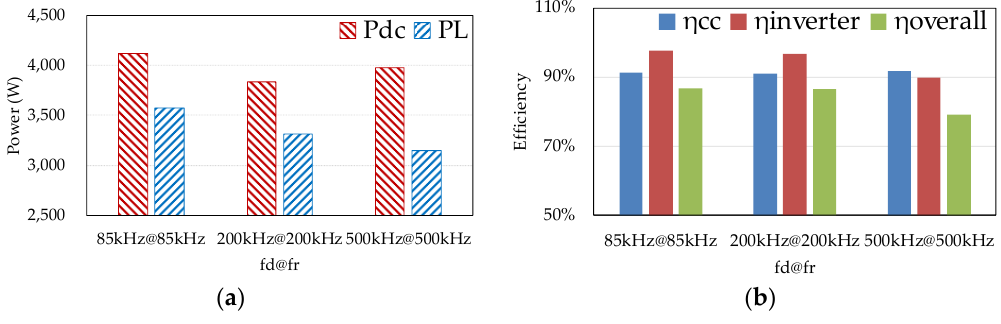
Figure 8. Three resonant WPT systems experiment results: ( a ) input and output power; ( b ) efficiency.